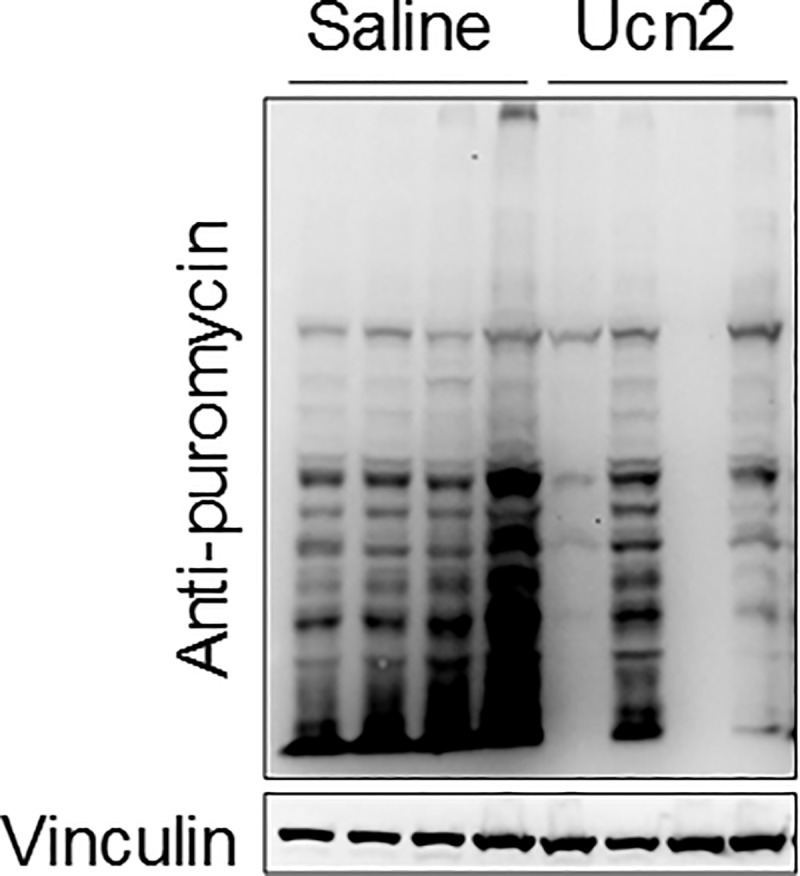
Protein synthesis reduced by AAV8.Ucn2 gene transfer in CHOW.Immunoblotting of puromycin-incorporated newly synthesized proteins in liver. Liver protein synthesis was decreased in mice that received Ucn2 gene transfer.